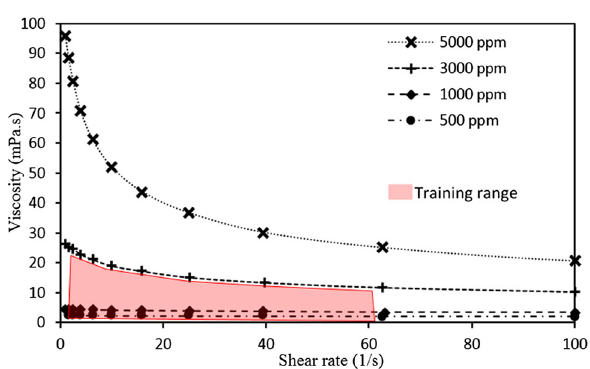
Fig. 9 Experimental data distribution for viscosity of polymer